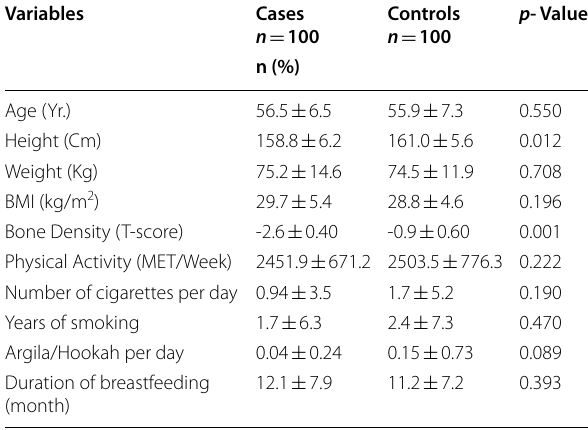
Table 2 Socio‑demographic, lifestyle, anthropometric and biochemical characteristics of the study